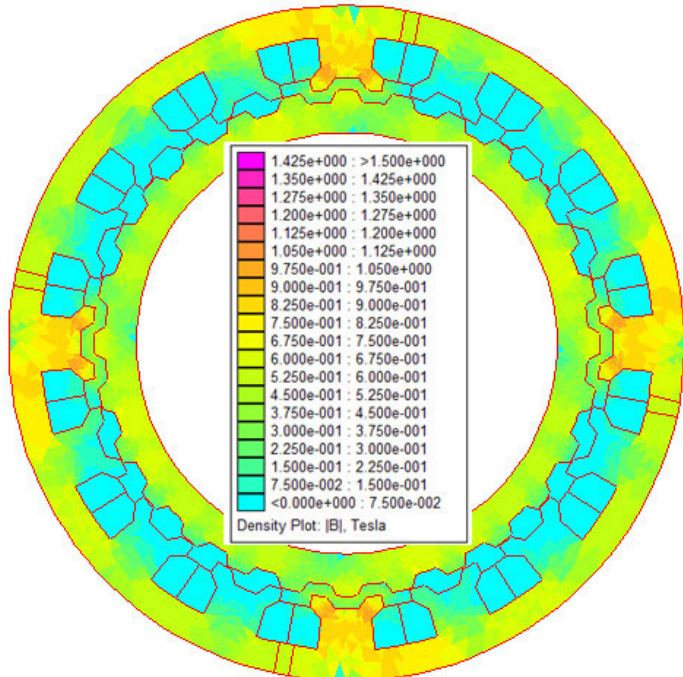
Figure 5. Opposition (unaligned) position and flux density distribution.